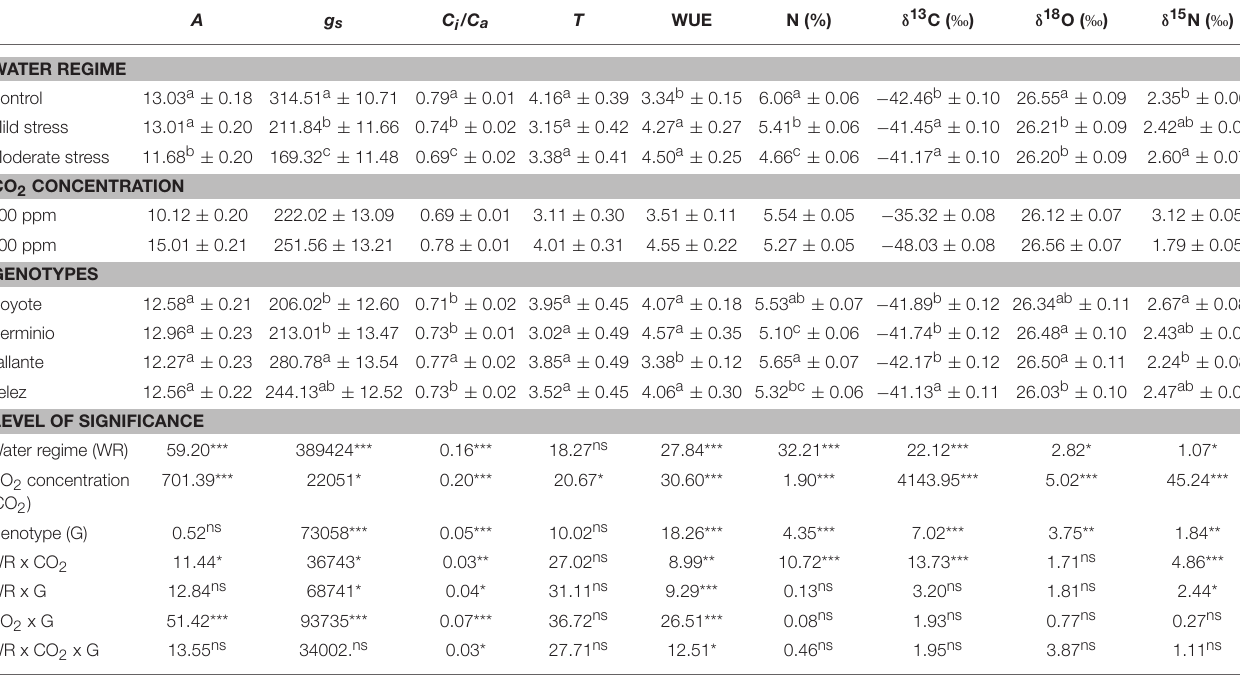
TABLE 2 | Water regime, CO 2 concentration, and genotype effects on gas-exchange parameters, carbon, oxygen, and nitrogen isotope composition, and nitrogen concentration of four sweet pepper genotypes grown under different combinations of CO 2 concentration and water supply. A g s C i /C